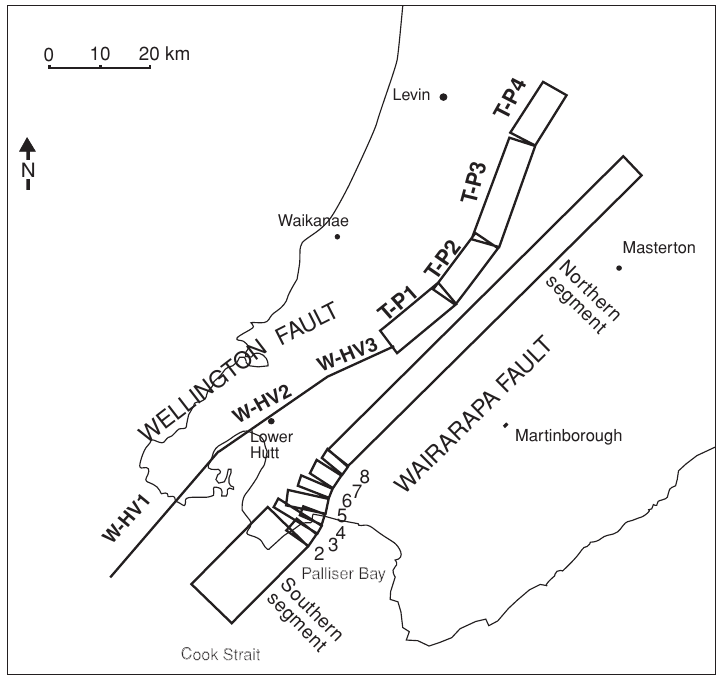
Fig. 5. The surface projection of the Wairarapa Fault, and the W-HV and T-P segments of the Wellington Fault. The flexed Wairarapa Fault Model is approximated by nine segments, whose dips decrease from 75 ° at the north- ern end to 60 ° at the southern end (Darby and Beanland, 1992). Although the northern segment has the same depth as the southern segment, its surface projection is